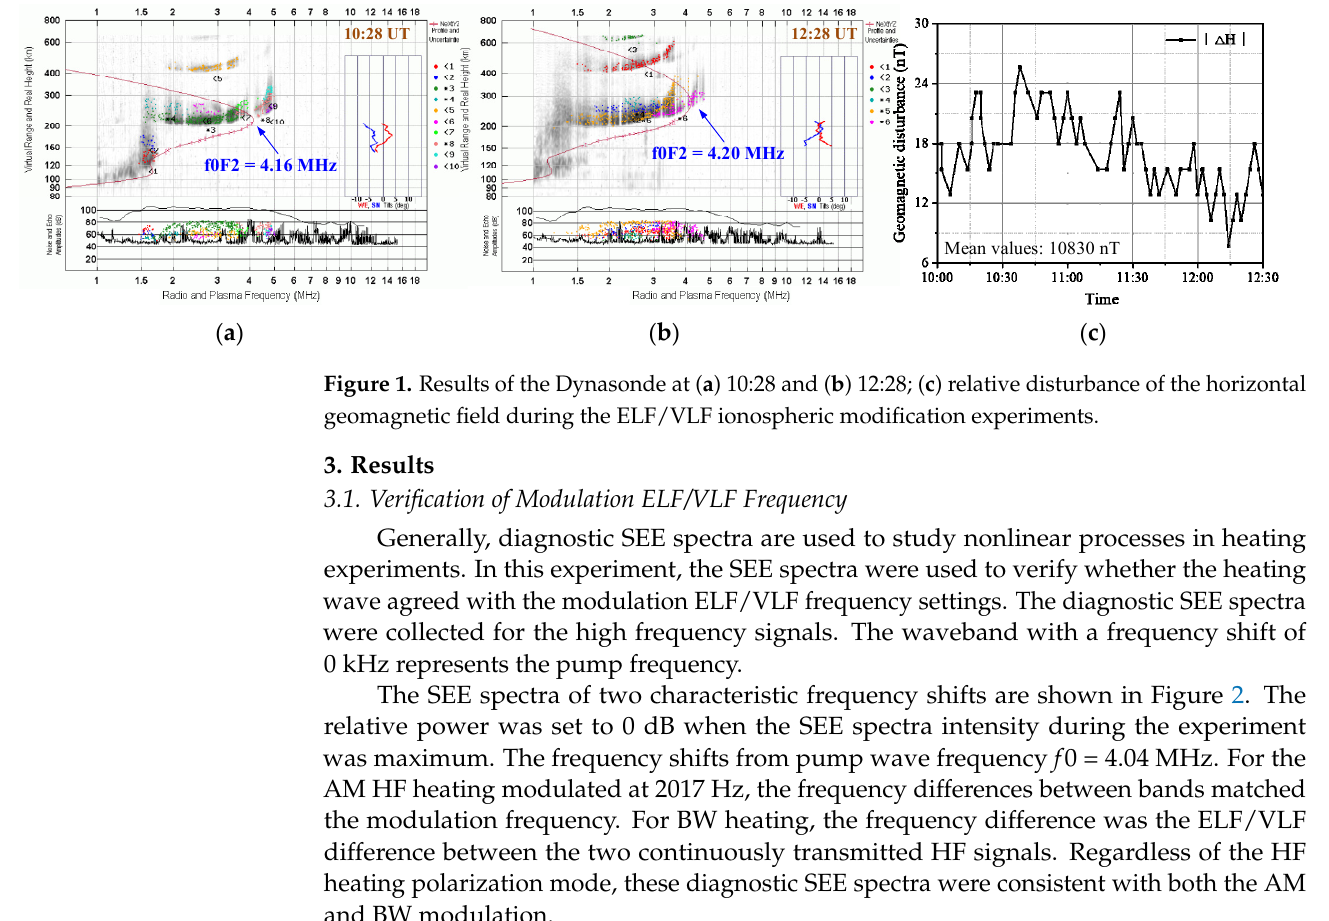
Figure 1. Results of the Dynasonde at ( a ) 10:28 and ( b ) 12:28; ( c ) relative disturbance of the horizontal geomagnetic field during the ELF/VLF ionospheric modification experiments.